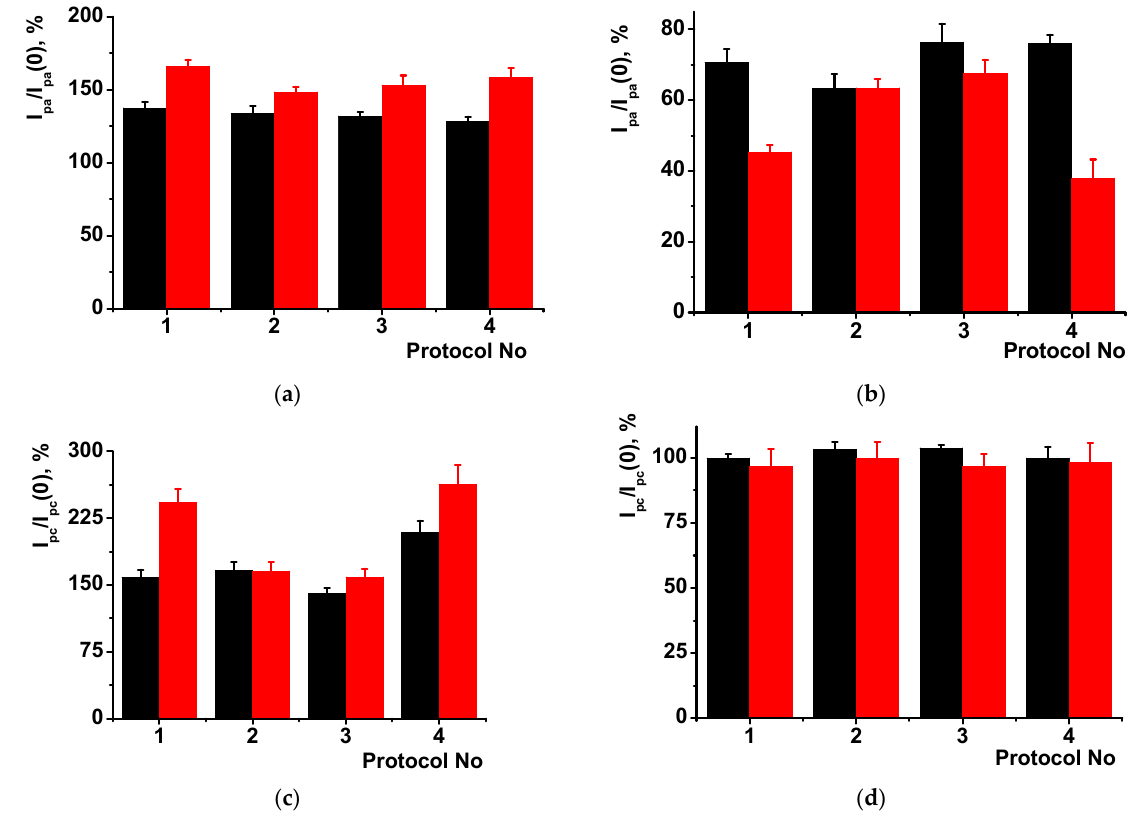
Figure 5. Relative changes in the peak currents ( I p ) caused by the DNA implementation in the PAA+CB (black) and PAA+ fMWCNTs (red) layers against those recorded prior to DNA adsorp ‐ tion ( I p (0)) for ( a ) monomer oxidation, ( b ) polymer oxidation, ( c ) monomer reduction, and ( d ) polymer reduction peaks. Protocol of DNA implementation: 1—drying DNA layer, 2–4—DNA incubation for 10, 20, 30 min, respectively. Measurements in 0.1 M phosphate buffer with 0.1 M NaNO 3 , pH 7.0, scan rate 100 mV/s. Average ± S.D. values were calculated for six individual DNA ‐ sensors.